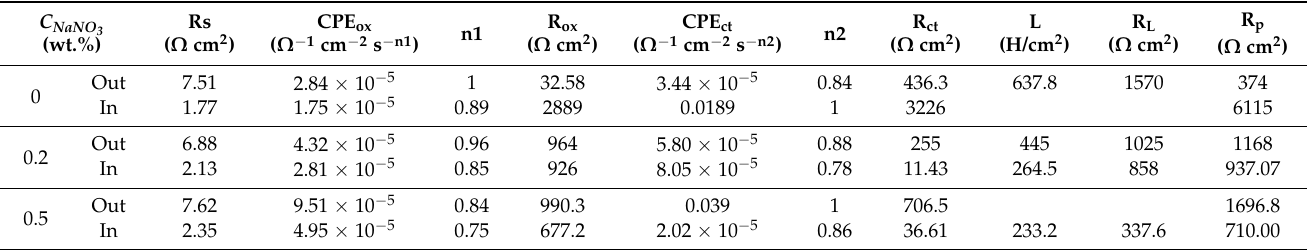
Table 1. The fitted electrochemical parameters for EIS of 7075-T651 inside the crevice and outside the crevice in acidic NaCl solutions with different concentrations of NaNO 3